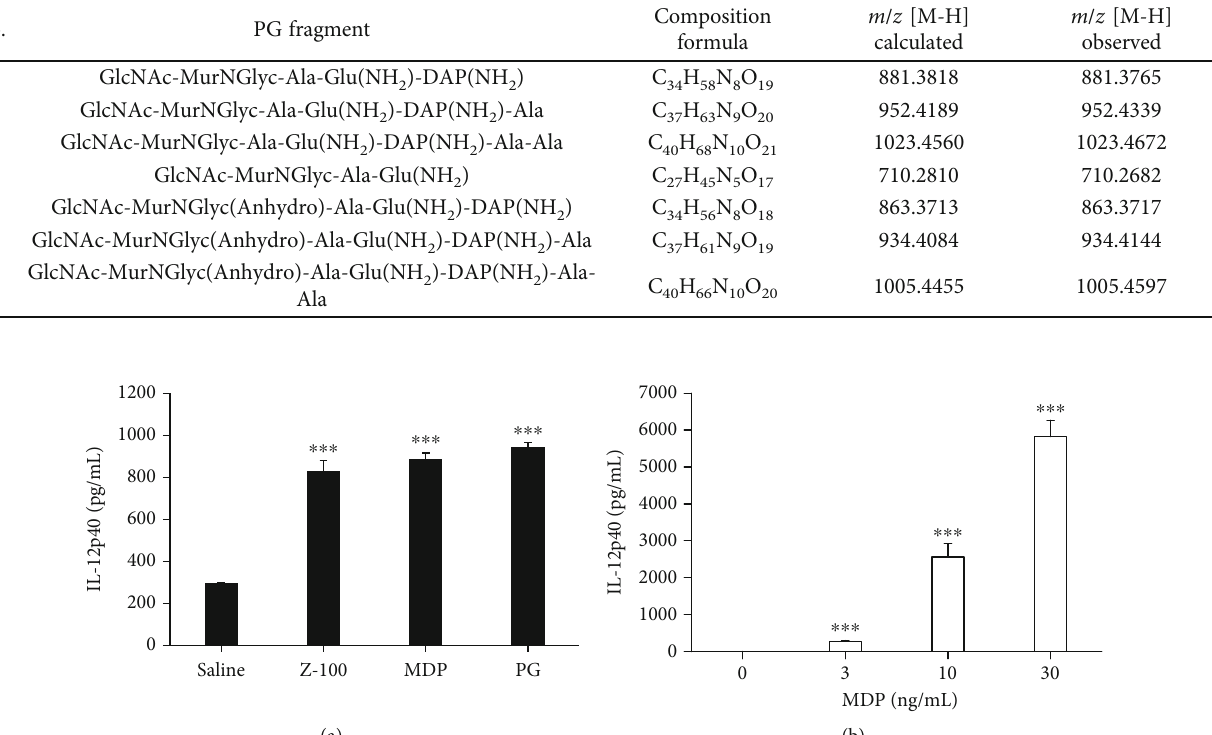
Table 2: Predicted structures for peaks 1 to 9 (from Figure 3(c)).